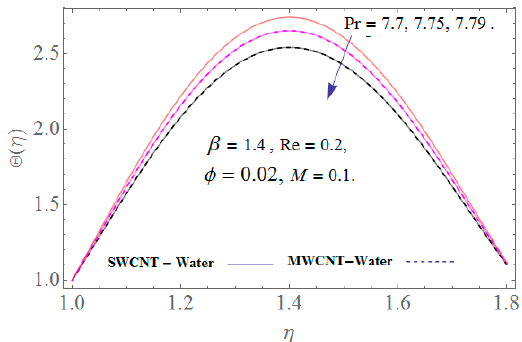
Figure 8. Impact of the Prandtl number versus temperature field.